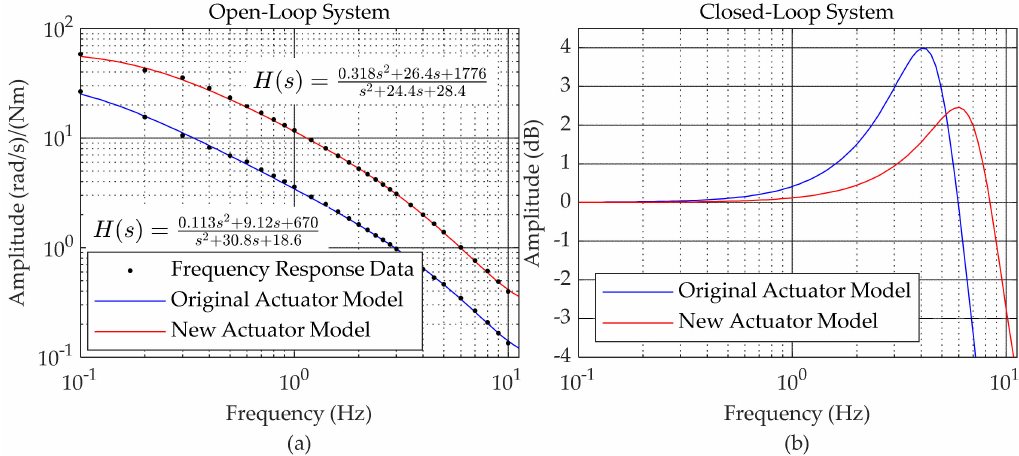
Figure 5. ( a ) Frequency response data and the identified actuator open-loop model from input torque to output velocity H ( s ) ; ( b ) A proportional-derivative (PD) controller was used to create a closed-loop model and the closed-loop bandwidth was